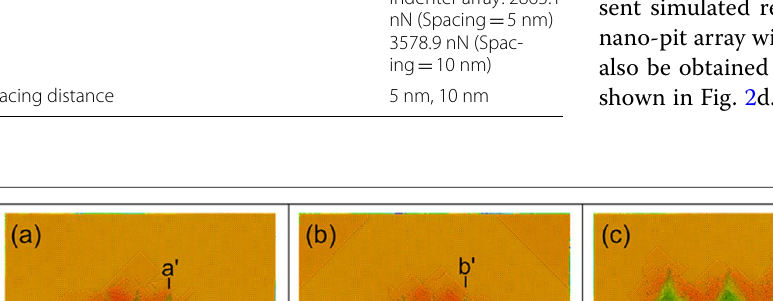
10 nm, d indenter array with =